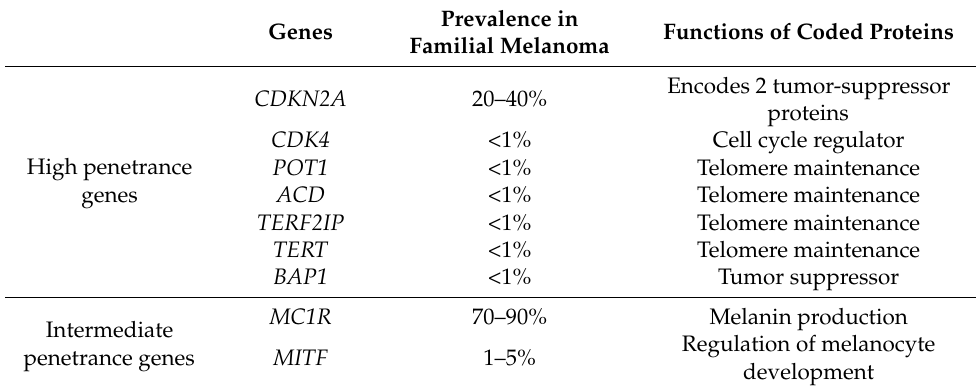
Table 1. Main genes associated with the development of familial melanoma, relative prevalence and function. Prevalence in Genes Functions of Coded Proteins Familial Melanoma